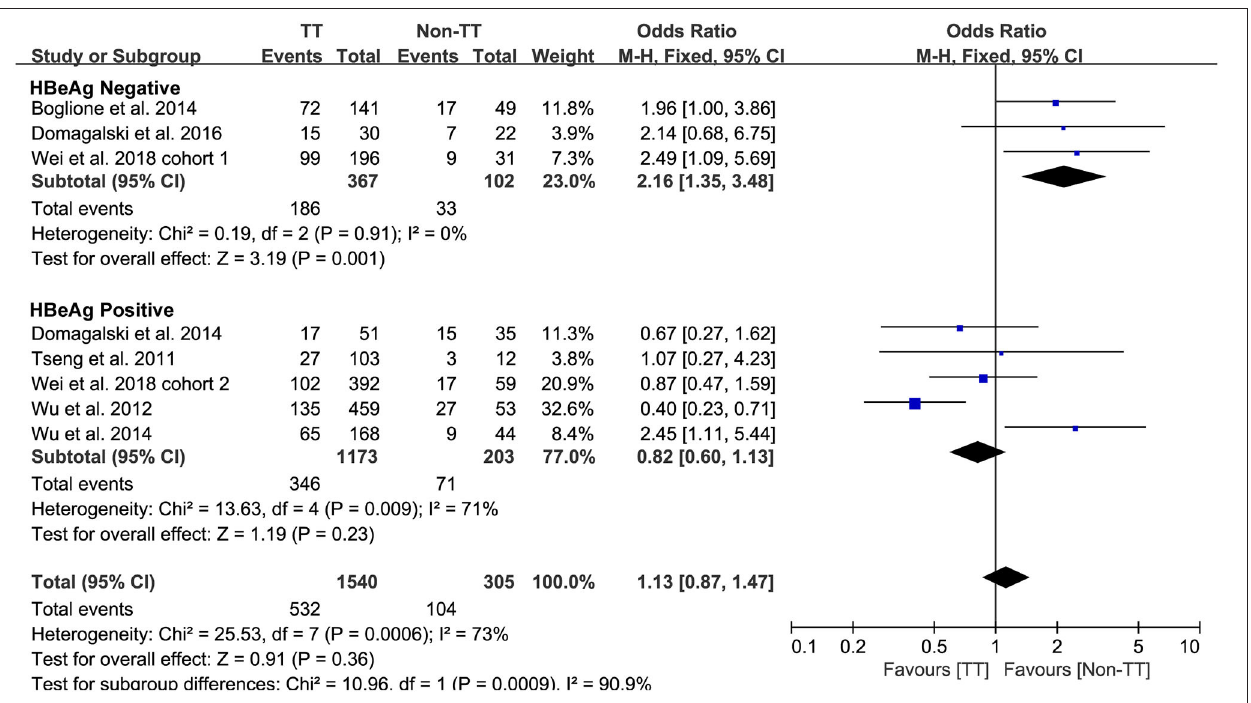
FIGURE 5 | Subgroup analysis of rs12979860, stratified by HBeAg.